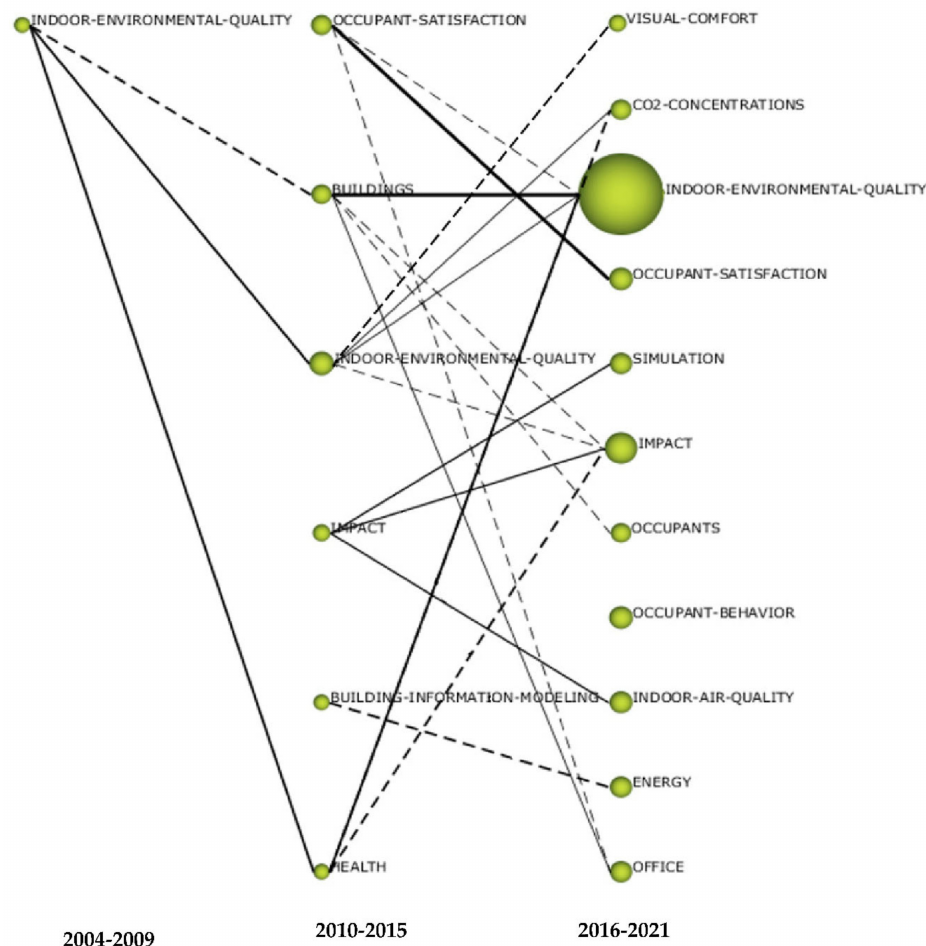
Figure 13. Thematic evolution map of IEQMI